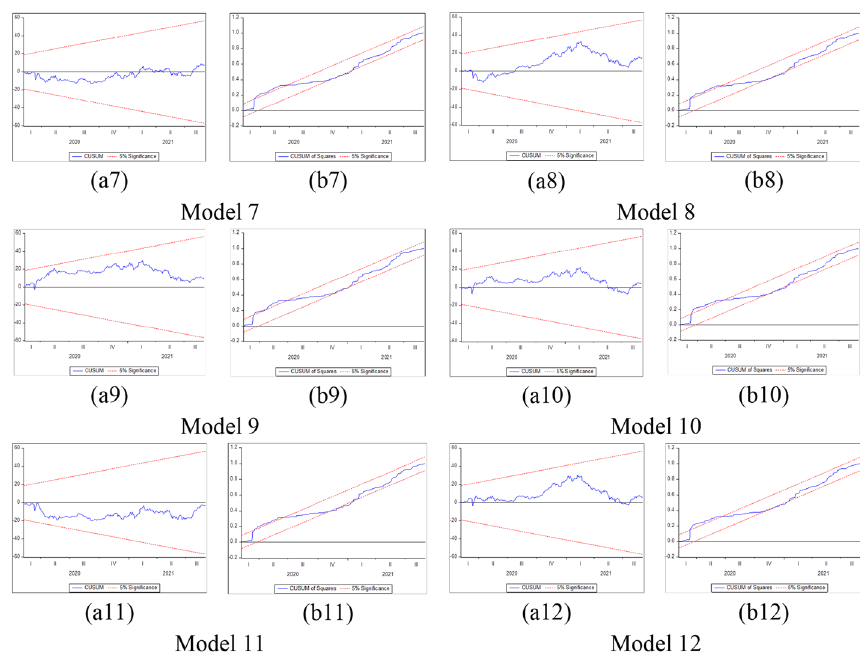
Fig. 5 NARDL plots of cumulative sum of recursive residuals—CUSUM (a7–a12) and cumulative sum square of recursive residuals—CUSUMSQ (b7–b12) for Models 7–12. Source Authors’ own work. Notes: The blue line is the solid line while the red lines that bounded the blue line are the critical bounds at 0.5. Variables’ description is provided in Table